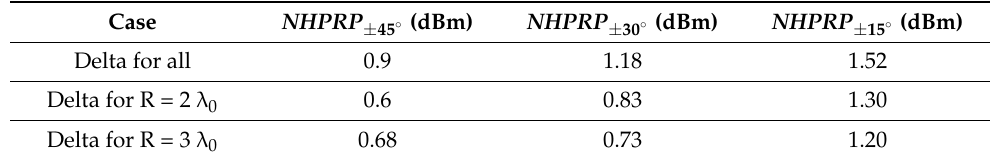
Table 2. Summarization of NHPRP s comparison.